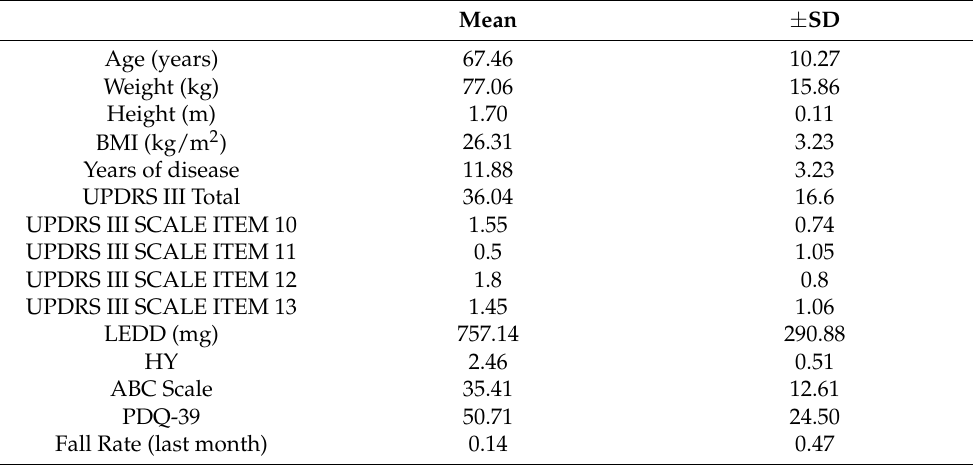
Table 1. Demographic data and characteristics of the study participants (n = 20). BMI: Body mass index; LEDD: Levodopa equivalent daily dose; H/Y: Hone and Yare